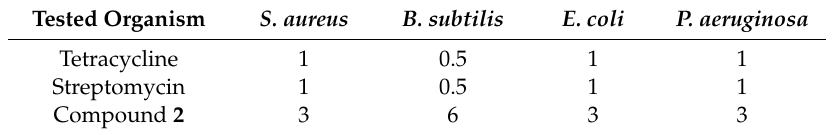
Table 1. Minimal inhibitory concentration (MIC) value of the synthesized compound 2 . Tested Organism